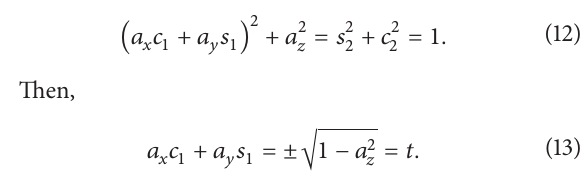
Figure 3: Three-axis intersection serial mechanism.